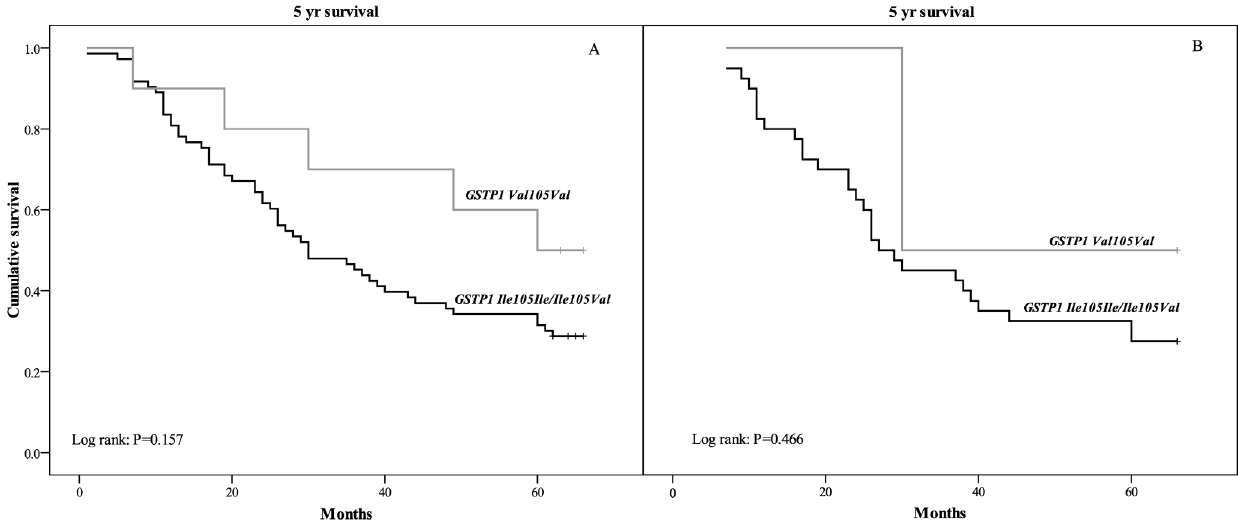
Figure 2. Survival analysis Kaplan–Meier curves according to GSTP1 polymorphism for overall mortality (A), as well as mortality of TCC patients on chemotherapy (B).